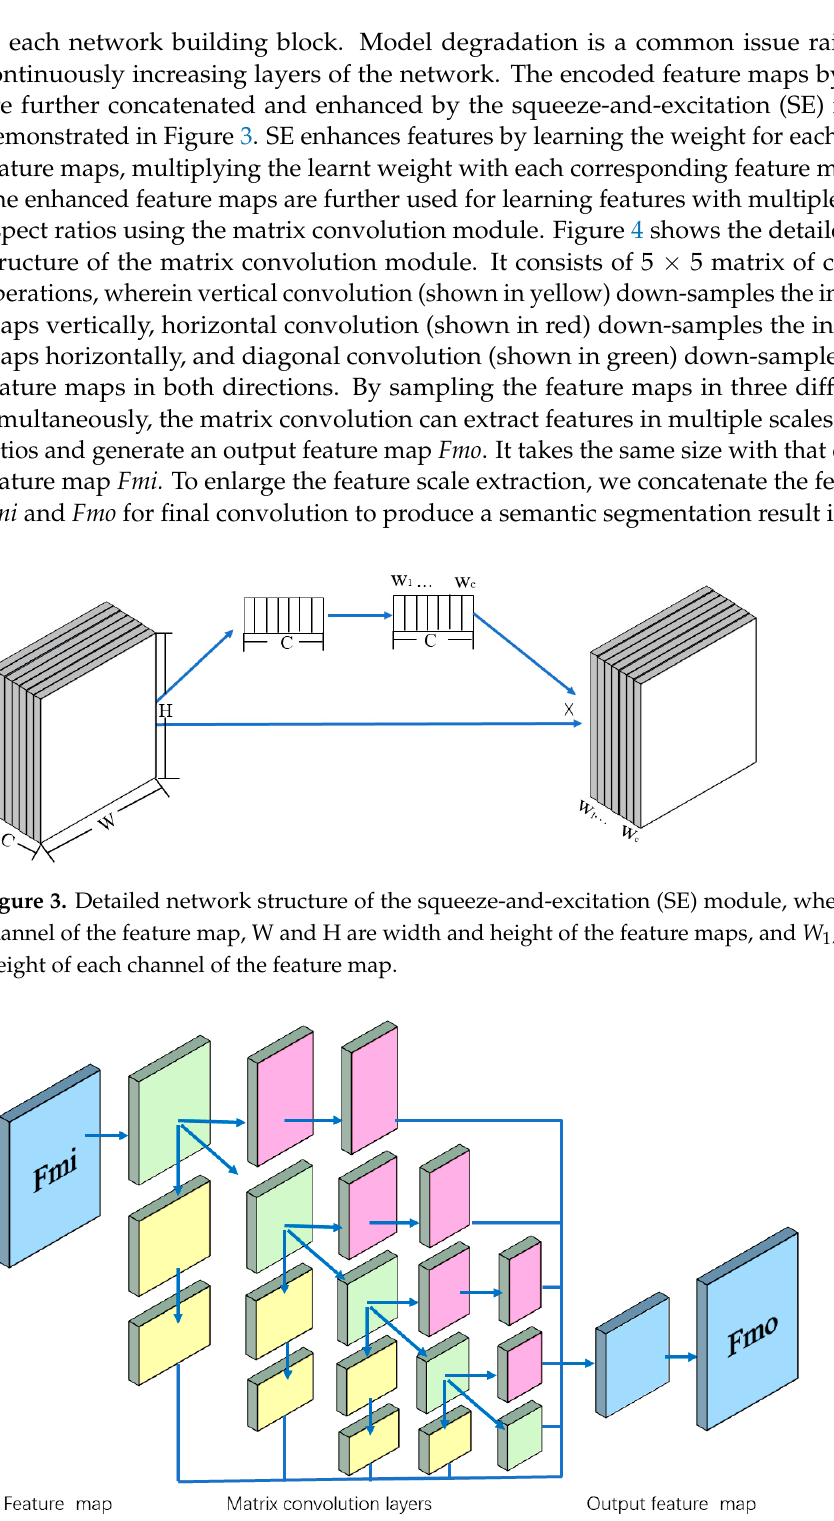
Figure 4. Network structure of the matrix convolution layers in our framework, wherein Fmi is the input feature map, Fmo is the output feature map, yellow feature maps are obtained by vertical convolution from the layer above, pink feature maps are calculated by horizontal convolution from the layer above, and green feature maps are achieved by diagonal convolutions.